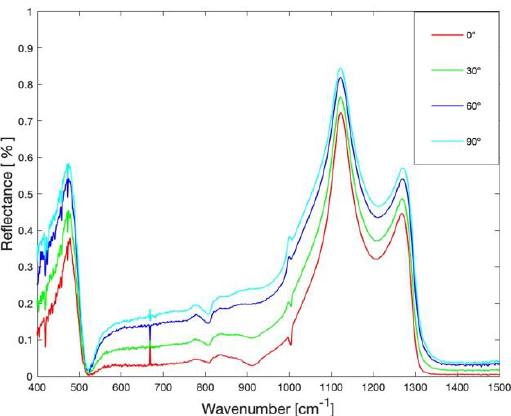
Fig. 2. FTIR reflection spectrum measured at an angle of incidence of 45° as a function of the different input polarization on MoO 3 film 500 nm-thick, grown by PLD on fused silica substrate, T=400°C, P O2 =10 -1